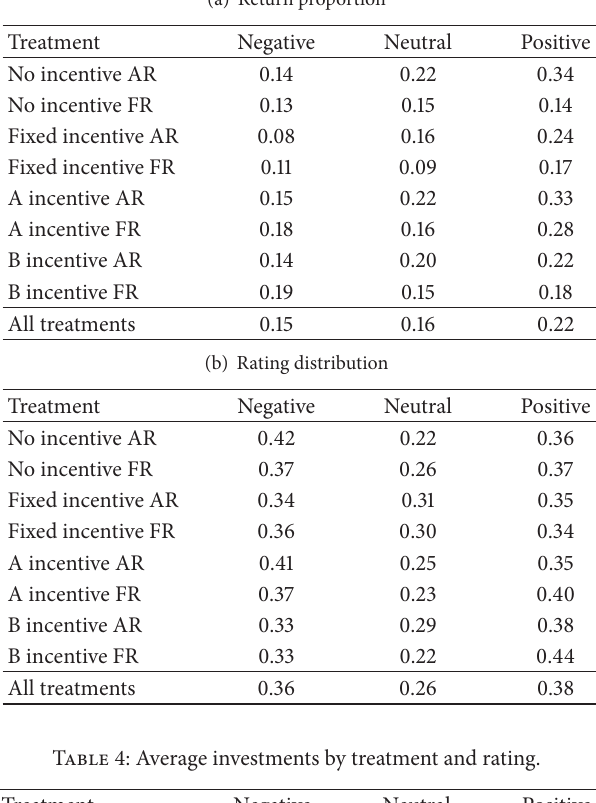
Table 3: Summary statistics by rating. Average return proportion by rating (a) and rating distribution per treatment (b). AR stands for “alternating roles” and FR for “fixed roles.”